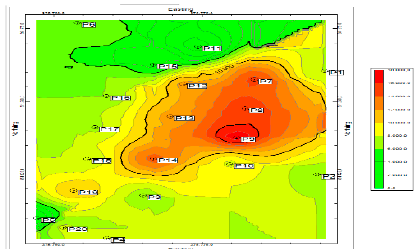
Figure 1. Modeling of the chloride concentration distribution on the soil